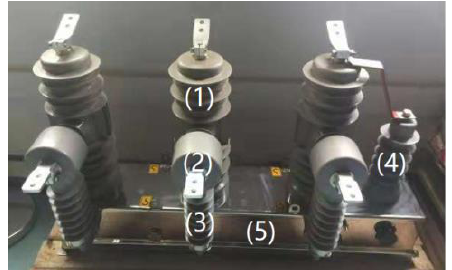
Figure 2. ZW32E−12 distribution switch circuit break.